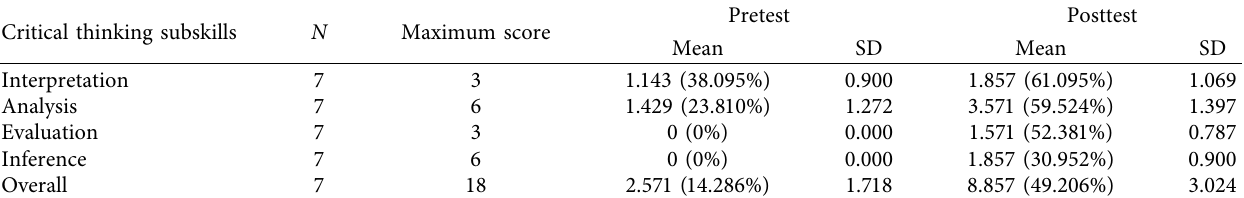
Table 7: Fair-achieving: means and standard deviations for pre- and post-test